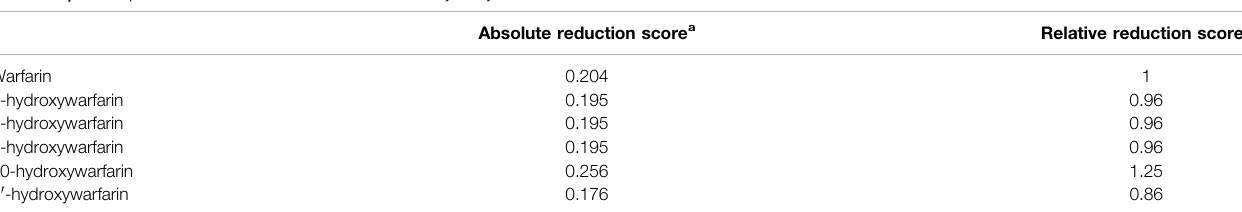
TABLE 1 | Model predictions for reduction of warfarin and hydroxywarfarin